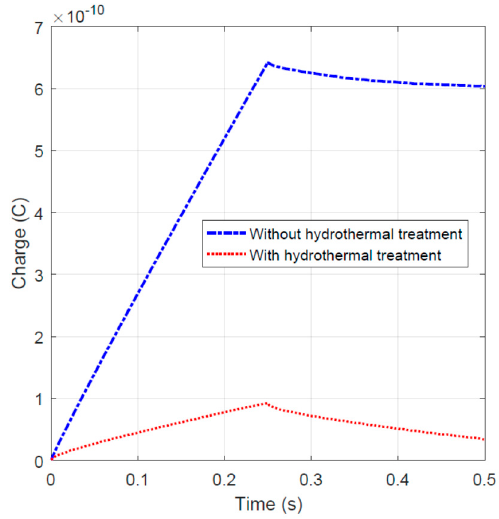
Figure 8. Charge–time relationship for specimens with and without hydrothermal carbonization treatment.